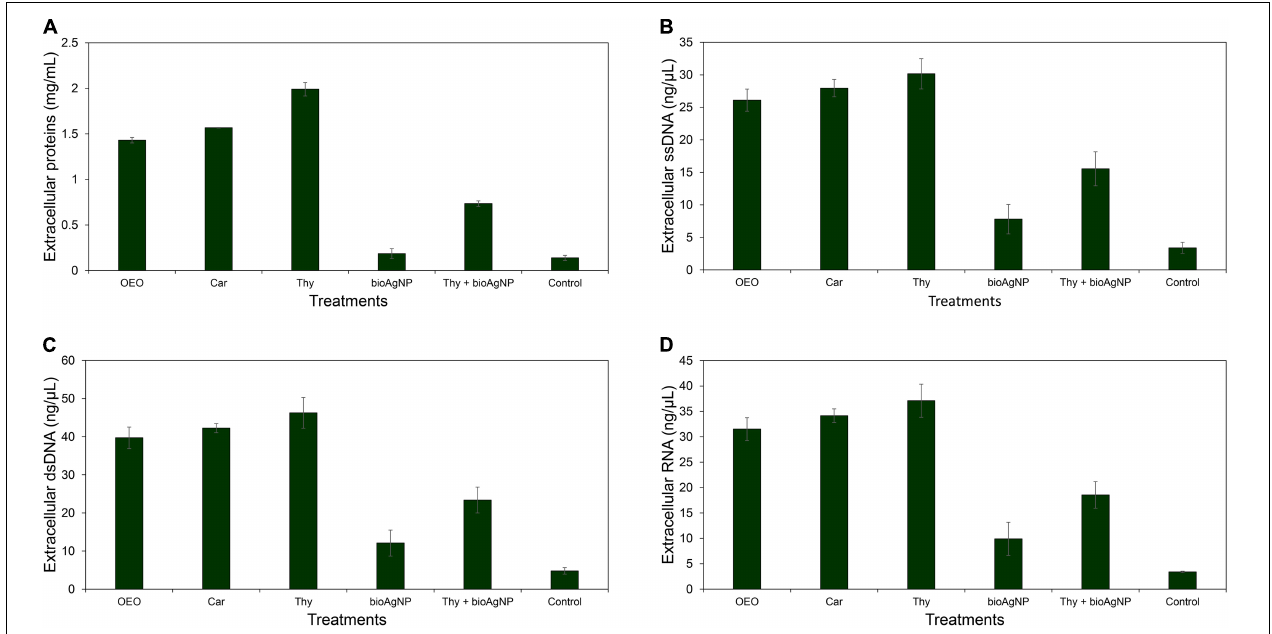
FIGURE 5 | Extracellular protein, DNA and RNA concentrations of E. coli ATCC 25922 exposed for 1 h to the oregano-derived antimicrobials and bioAgNP individually and in combination at subinhibitory concentrations. Control indicates extracellular biomolecule concentration of bacterial cells without the antimicrobials. (A) Extracellular total proteins (mg/ml). (B) Extracellular single-stranded DNA (ssDNA; ng/ µ l). (C) Extracellular double-stranded DNA (dsDNA; ng/ µ l). (D) Extracellular RNA (ng/ µ